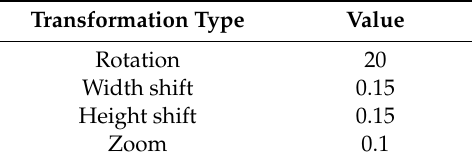
Table 6. Setting Data Augmentation Value.